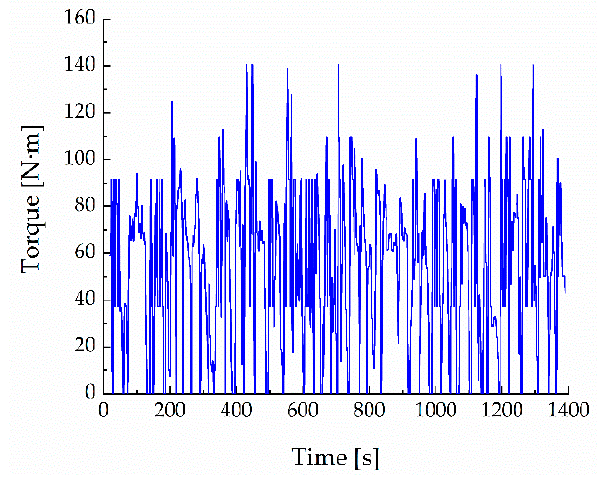
Figure 9. Load spectrum ignoring braking torque.